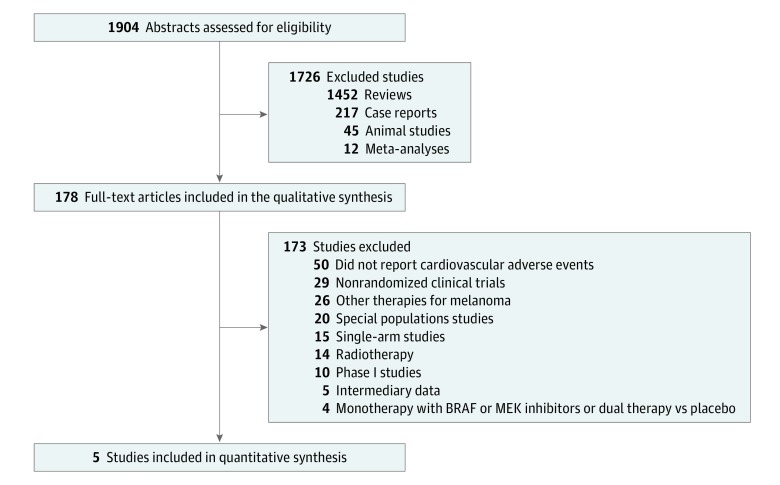
PRISMA Selection Flowchart